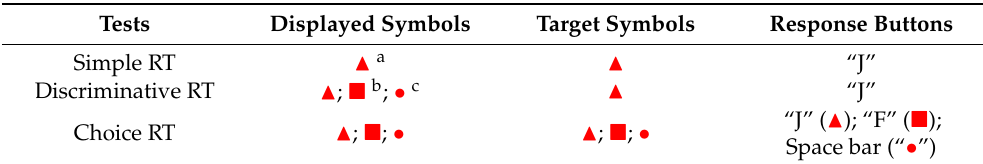
Table 2. Details of the reaction time